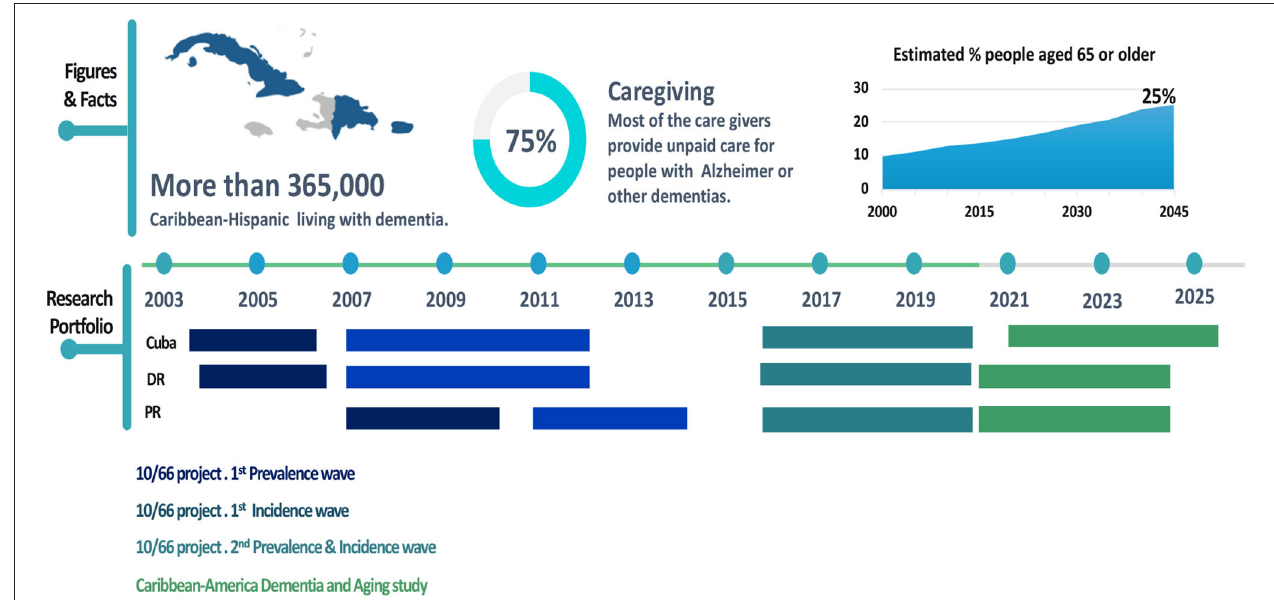
FIGURE 1 | Dementia in the Caribbean Hispanic Islands: Research Agenda, Figures, and Fact.